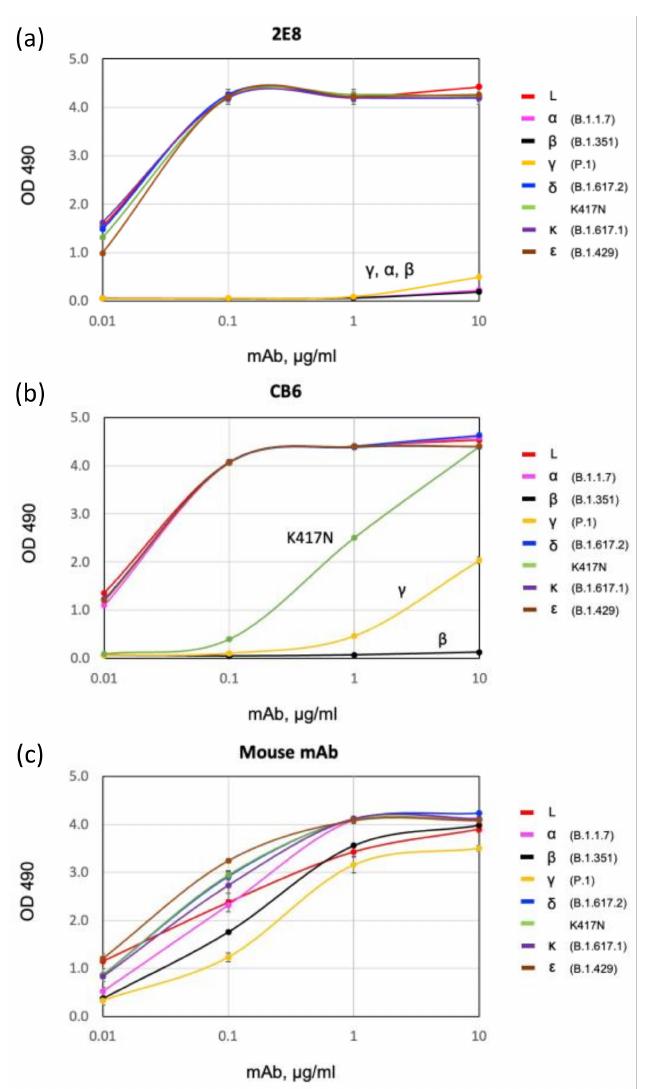
Figure 3. Differential recognition of SARS-CoV-2 variant spike antigen by direct ELISA. The 2E8 ( a ), CB6 ( b ), and the mouse anti-S1 mAb ( c ) were tested for binding to spike antigens adhered to an ELISA plate: L RBD (Wuhan-Hu-1), α S1 (B.1.1.7), β S1 (B.1.351), γ S1 (P.1), δ RBD (B.1.617.2), K417N RBD, κ RBD (B.1.617.1), ε S1 (B.1.429). Error bars =